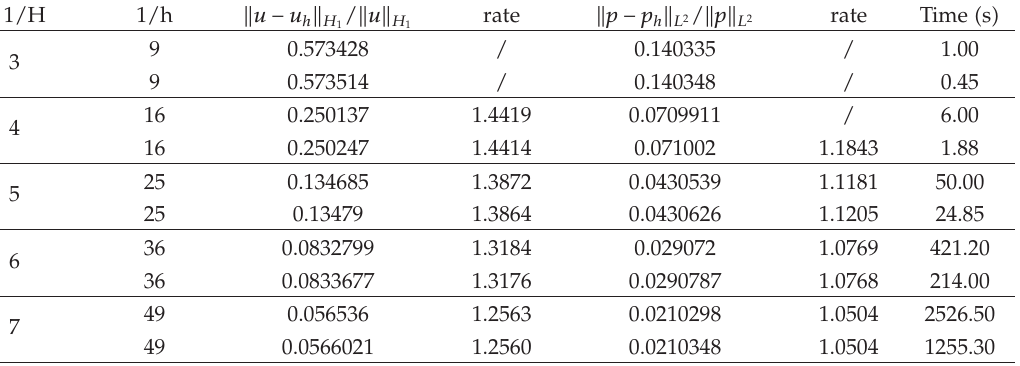
Table 1: Comparison of the one-level stabilized method with the Oseen two-level stabilized